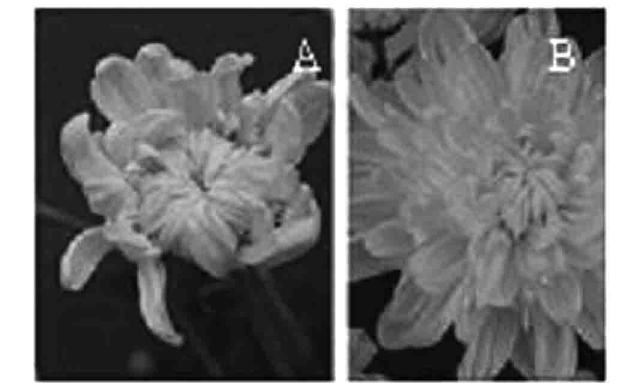
Fig. 1 - Induced somatic mutations in chrysanthemum cv. Snow Ball after 10 Gy gamma radiation treatment. (A) control, white- coloured flowers; (B) mutated, yellow-coloured flower.